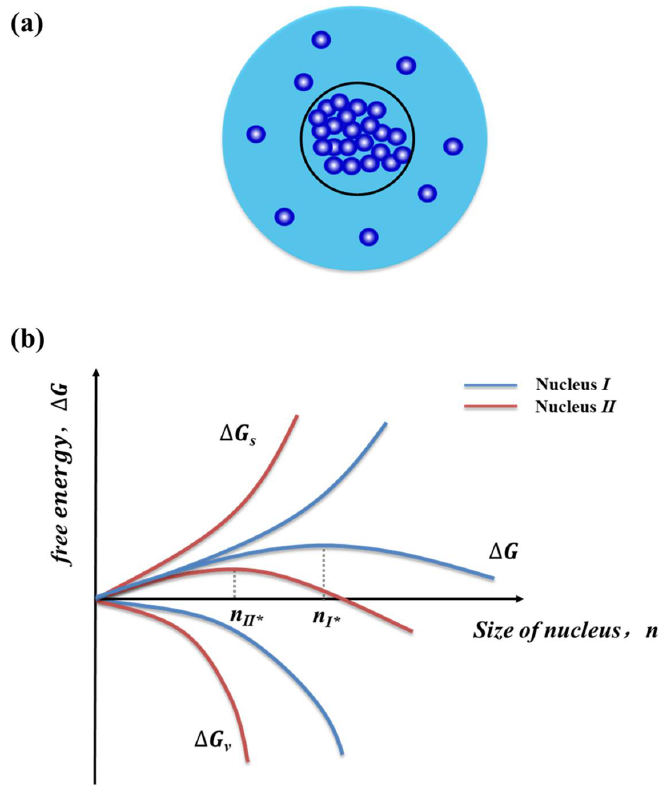
Figure 1. Cluster formation and the associated changes of free energy during crystal nucleation. ( a ) Nanoscopical formation of new phase via molecular clustering and ( b ) free energy diagram of crys- tal nucleation showing the formation of critical nucleus size and supersaturation influence wherein a high supersaturation in the solution leads to a lower critical size of the nucleus (i.e., (cid:1866) (cid:2893)∗ > (cid:1866) (cid:2893)(cid:2893)∗ ).